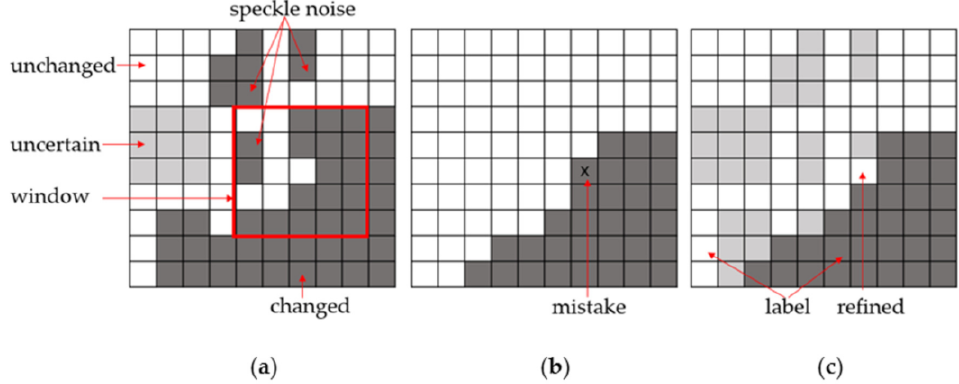
Figure 2. Illustration of the filtering function. ( a ) The image (cid:102) DI obtained by clustering operation. ( b ) The image L n , α obtained by Equation (3). ( c ) Changed and unchanged pixels are selected as labels. The image (cid:102) DI is first filtered by Equation (3) to eliminate the speckle noise, as shown in ( b ), then refined to obtain the label by Equation (4), as shown in ( c ). Pixels in grey color in ( c ) contain speckle noise and truly changed pixels, which will be classified by